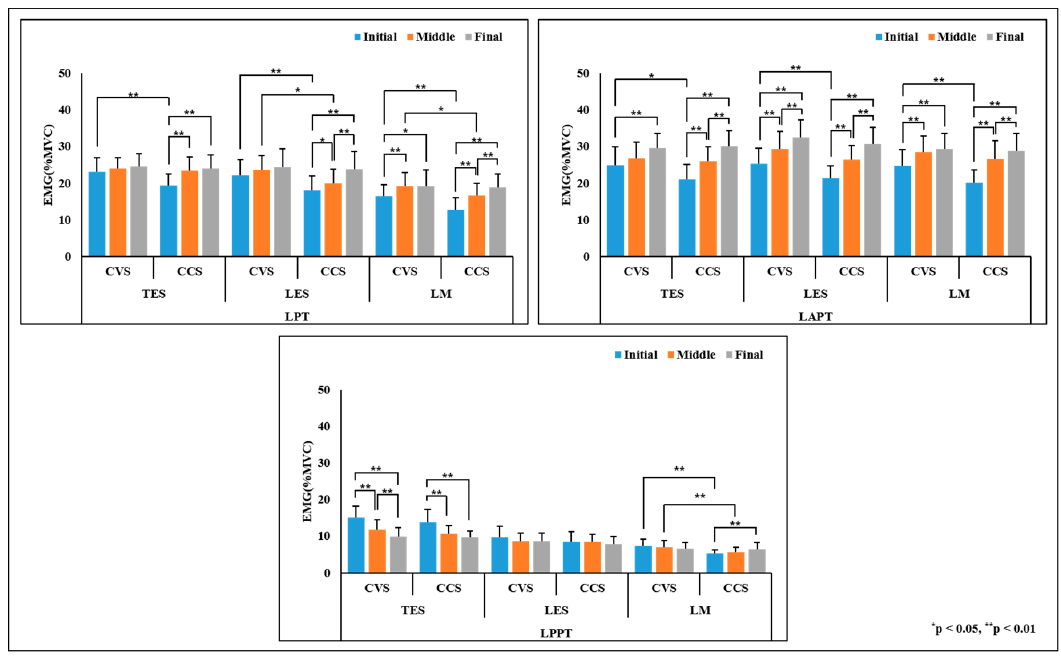
Figure 5. Differences in the muscle activities between the convex side (CVS) and concave side (CCS) among the initial, middle and final test.